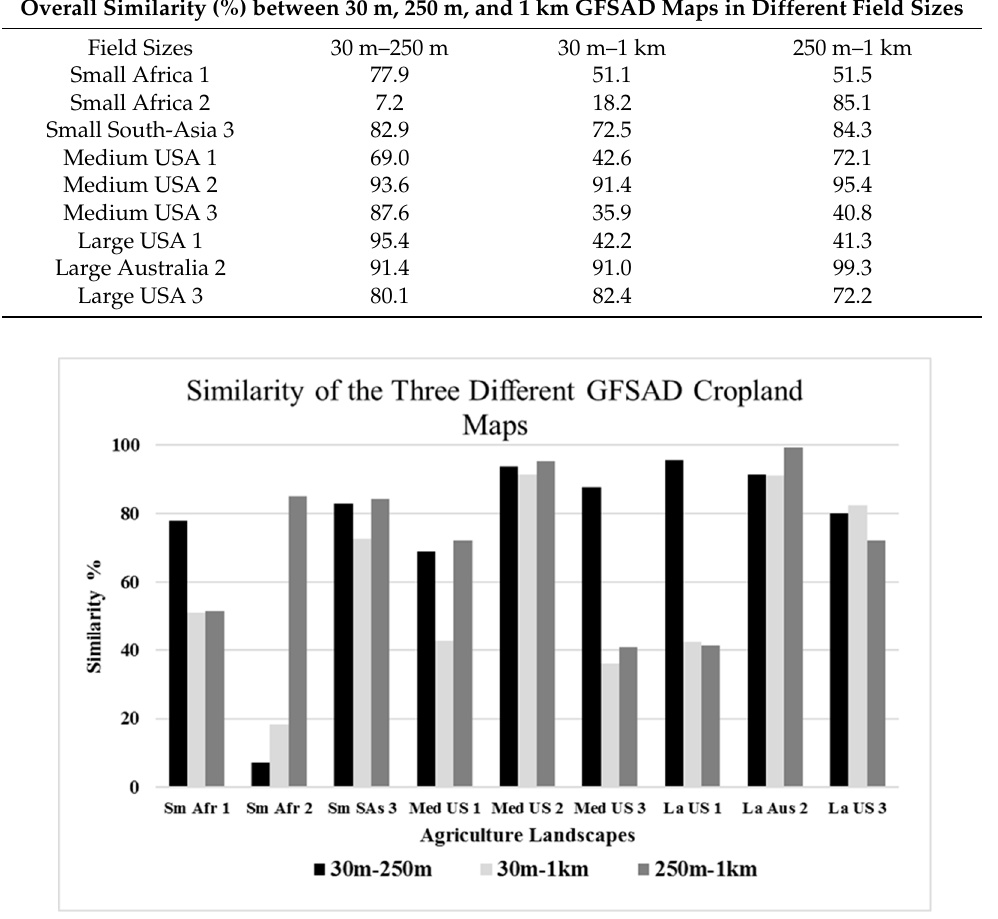
Figure 10. The similarity in the cropland areas mapped at the three different spatial resolutions in different agriculture landscapes. Table 15. Omission Error (OE) and Commission Error (CE) of crop in the coarser-resolution maps as compared to fine resolution for nine different study sites.